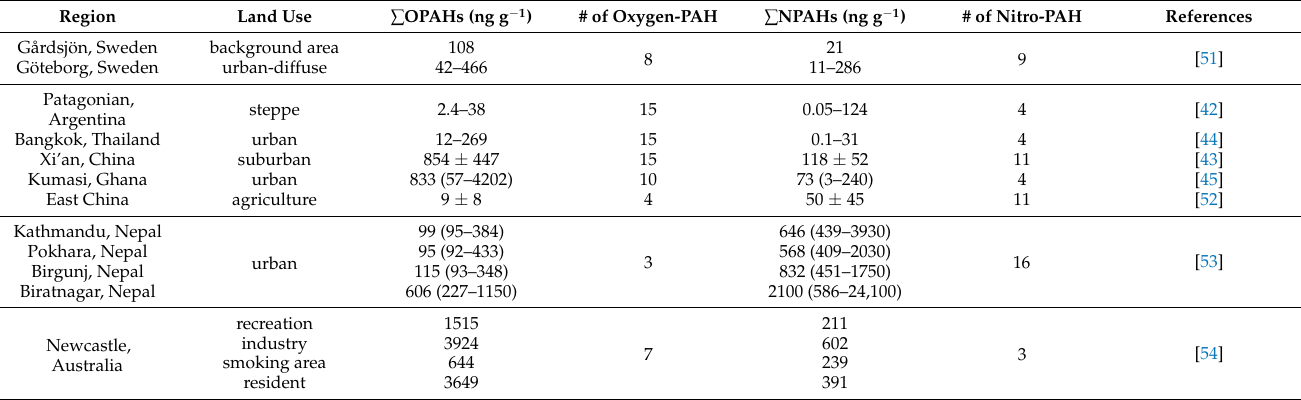
Table 1. The occurrence of OPAHs and NPAHs in different types of soils.